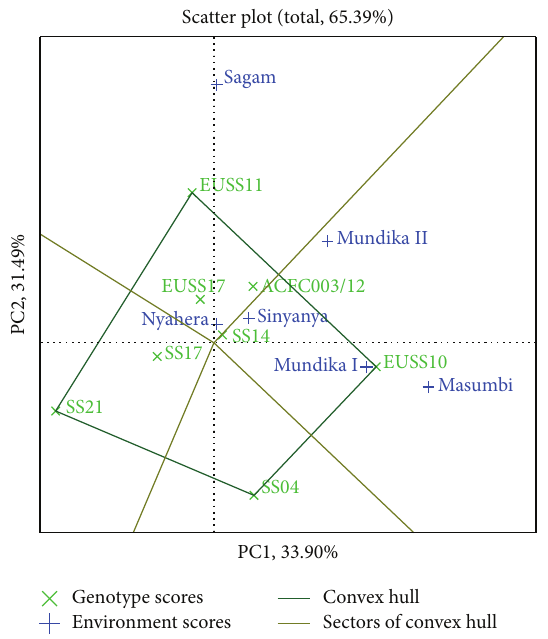
Figure 5: The which-won-where view of GGE biplot for ethanol yield.